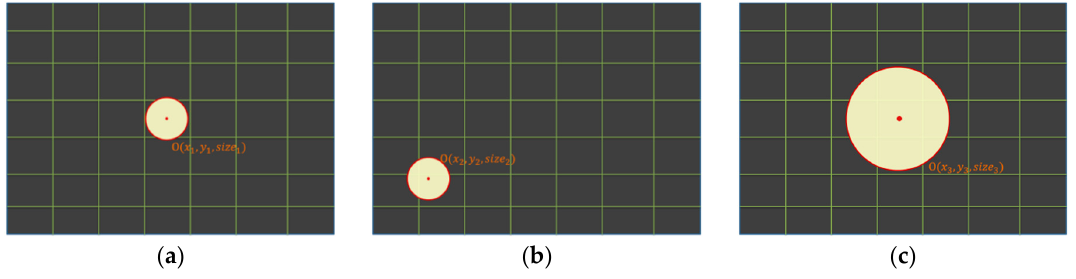
Figure 6. Definitions of object-tracking values of ( a ) benchmark, ( b ) orientation, and ( c ) distance.